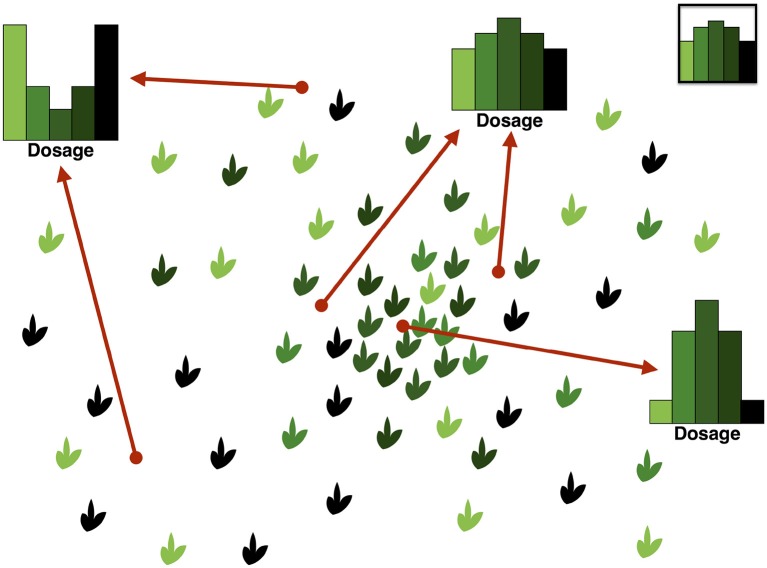
Illustration of the Dosage Distribution (including homozygotes) in a panmictic autotetraploid population with density-dependent selfing rates. In this example, we assume for simplicity that segregating alleles are at intermediate frequency in the population; their dosage in each individual is represented by the color lightness. Since the average frequency is the same everywhere, the average dosage also is. However, by contrast, the DD depends strongly on the sampling location because of variations in the local spatial density. Sampling individuals at random across different locations would result in an average DD like the one in the top-right inset. On the other hand, sampling around a given location would result in different DDs, as illustrated. Locations in the central region tend to have DDs similar to the Hardy–Weinberg ones, while peripheral locations show a large excess of homozygotes because of sampling.